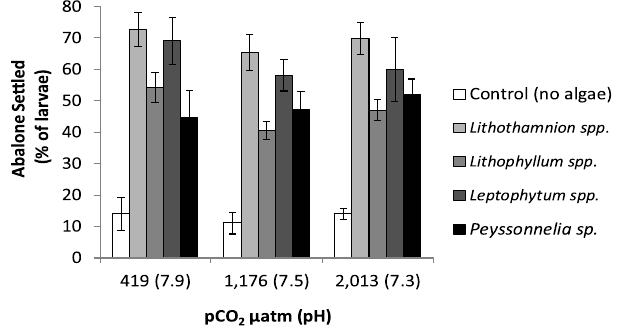
Figure 3. Abalone settlement (as percent of larval settled and attached) on the four CCRA genera and in control vials with no algae, and across the pCO 2 treatments representing ambient conditions (419 µ atm and pH of 7.9), high pCO 2 (1,176 µ atm and 7.5 pH), and extreme pCO 2 (2,013 µ atm and 7.3